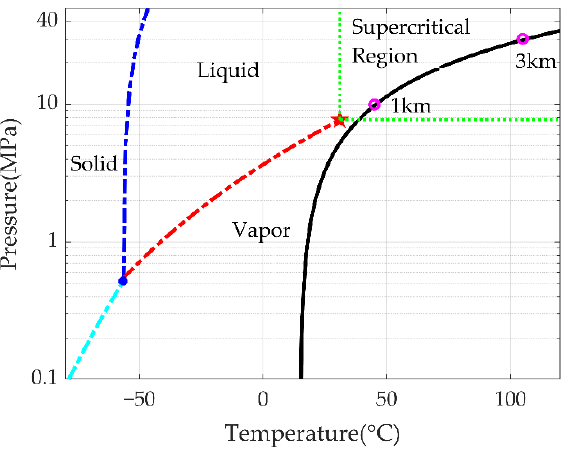
Figure A1. The phase diagram of pure CO 2 (refer to Ref. [26]), the black line is the temperatures and pressures of different depths, with a geothermal gradient of 30 °C/km and a pressure gradient of 10 MPa/km.